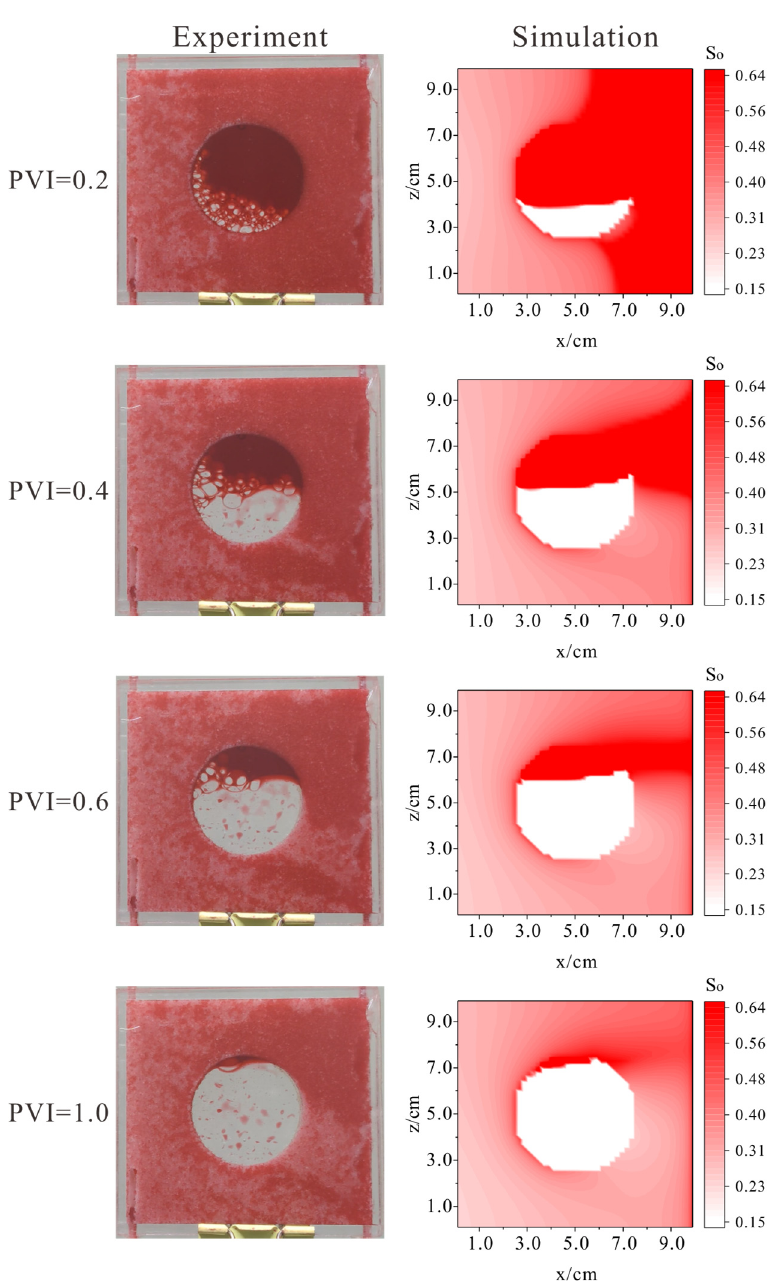
Figure 14. Comparison of the oil saturation distributions in the experiment and numerical simulation at four different PVIs for Case 2 in Section 2. Water (transparent) displaces oil (red) from left to right.